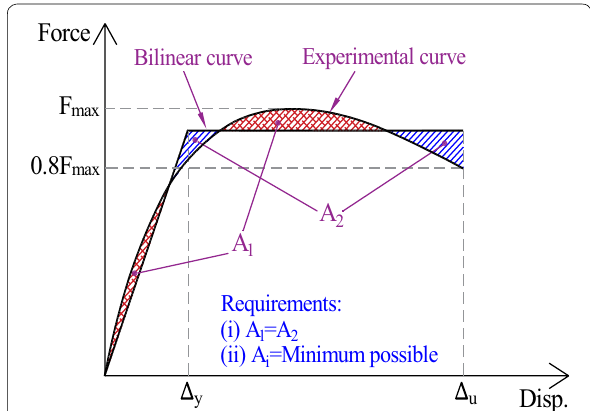
Fig. 20 Bilinear method to determine the yield displacement (Seifi et al.